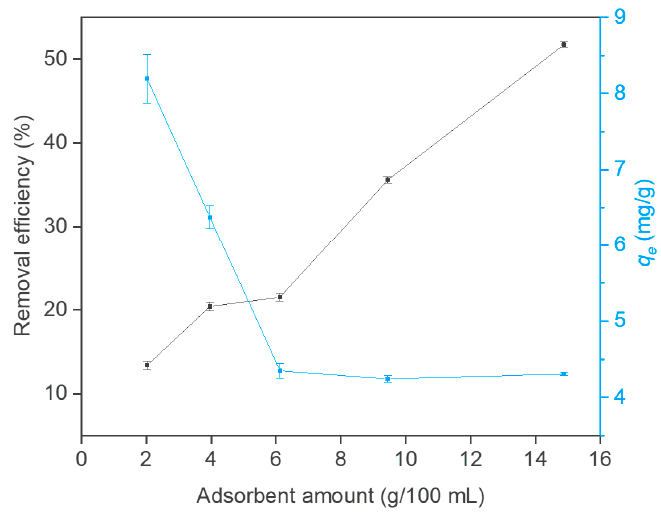
Figure 4. Influence of foam concentration on removal e ffi ciency and adsorption capacity of phenolic compounds in OMW.